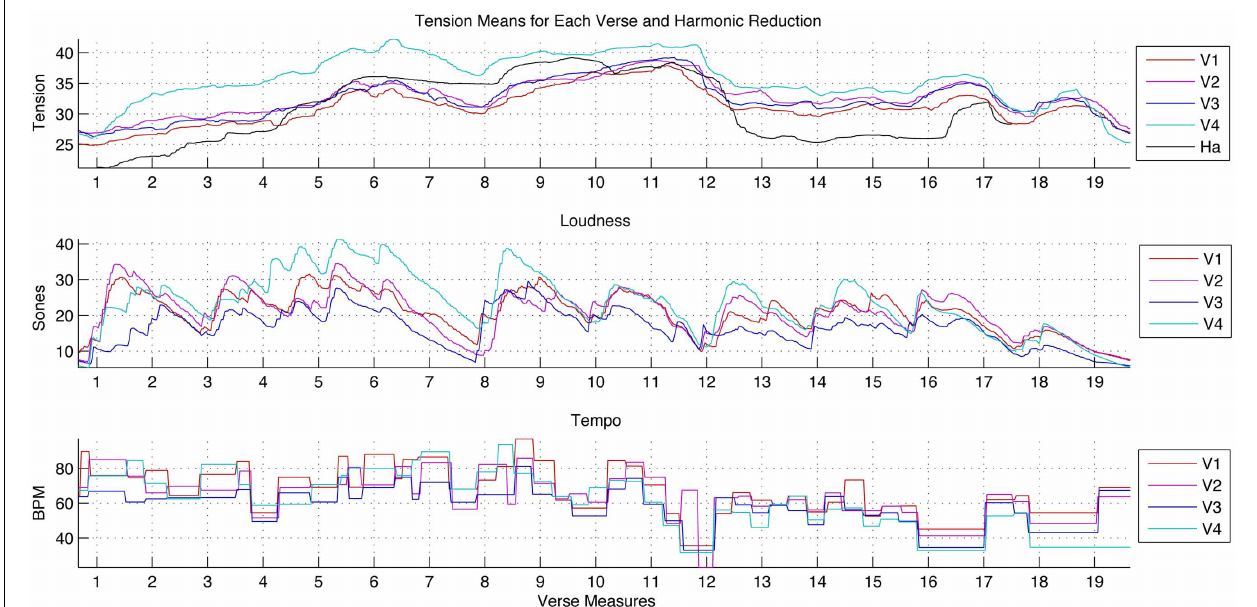
FIGURE 5 | The average musical-tension-rating time series for the harmonic reduction and each performed verse; the acoustic loudness of each verse in the performed rendition aligned to metrical time; and the